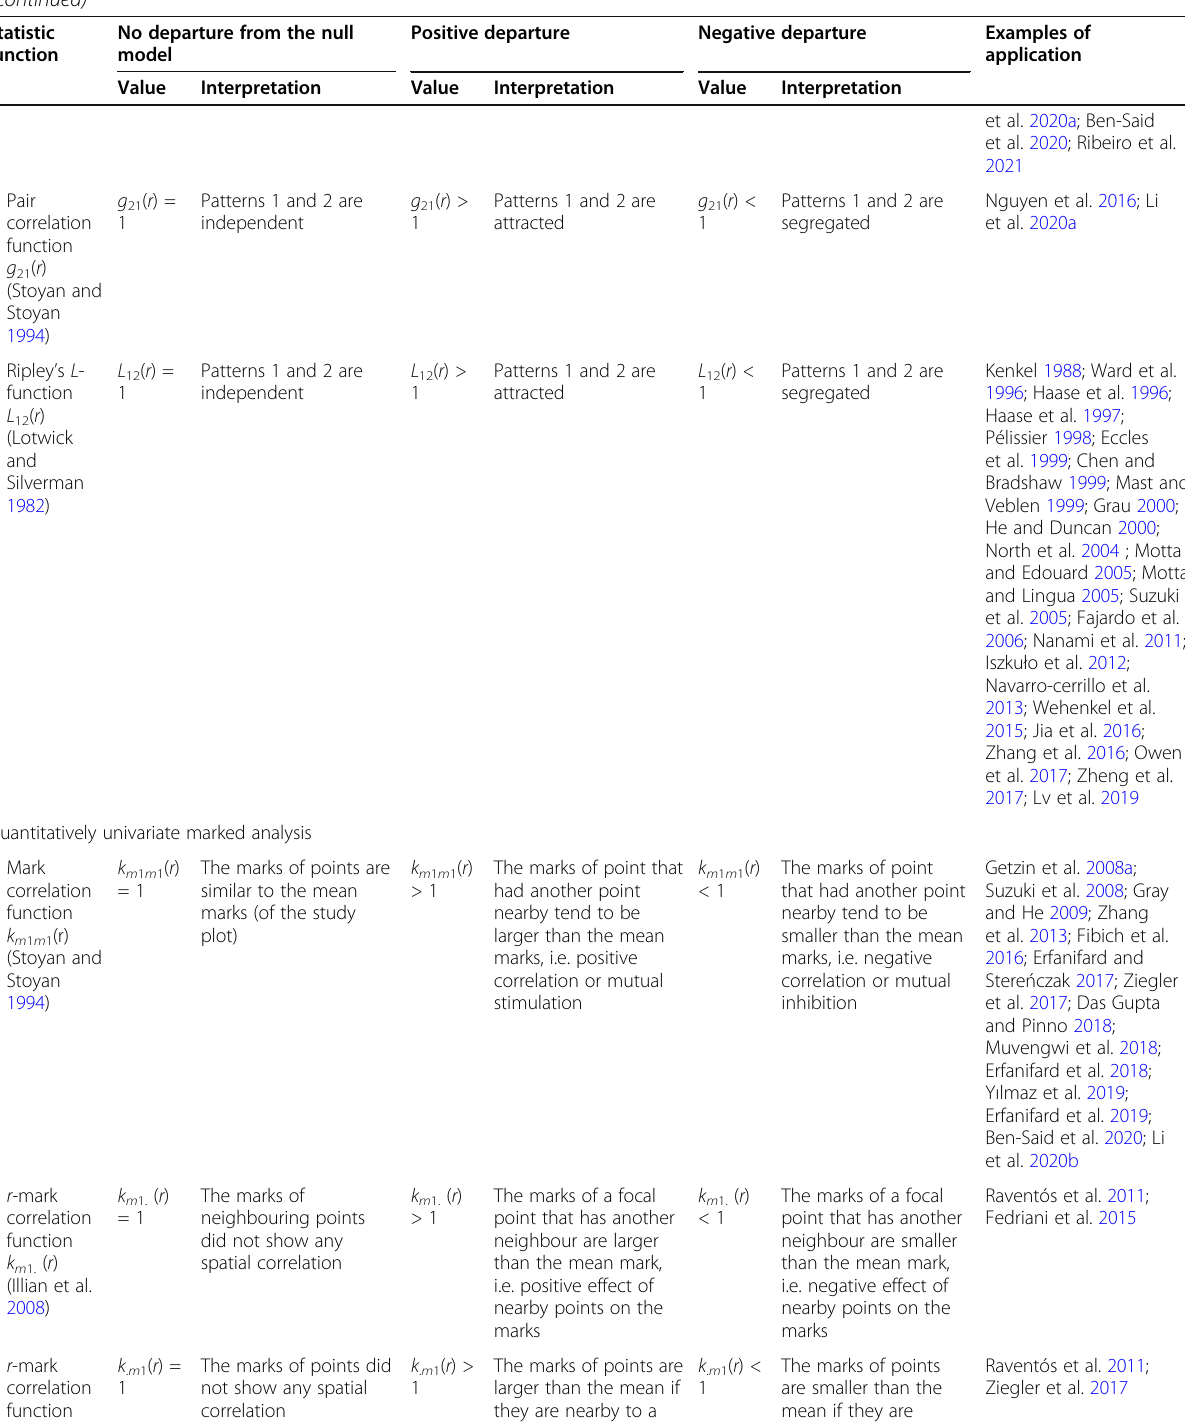
Table 1 Second-order summary statistics commonly used in spatial point-pattern analysis. In the univariate analysis, only one pattern is involved (e.g. one species, one size or age class, one life stage, etc.), while in the bivariate version two patterns (1 and 2) are investigated (e.g. two different species, two size classes, two life stages, etc.). For the mark correlation analysis, the most studied mark is by far tree diameter. In the case of random labelling analysis, the marks usually consist of tree status (e.g. dead vs living). For all analysis types, positive, negative, or absence of departure from the null model simulation envelopes occurs at a given scale